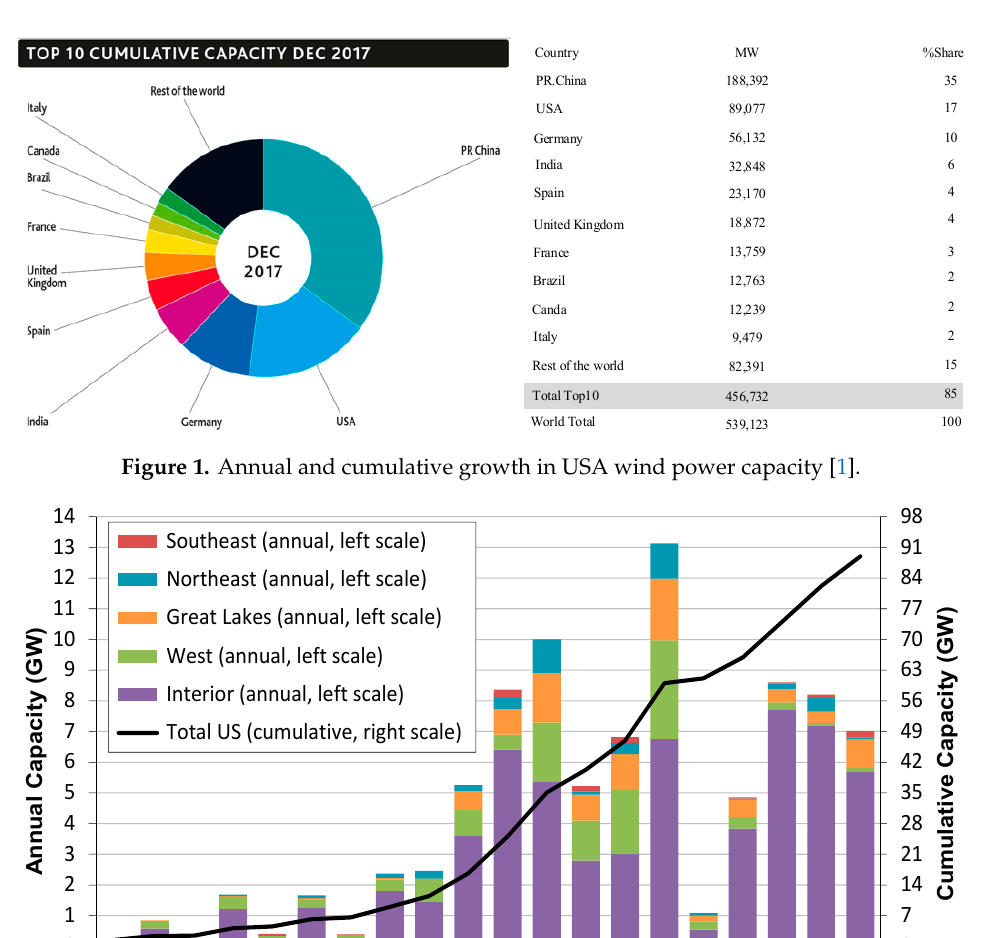
Figure 2. Annual and cumulative growth in USA wind power capacity [2].